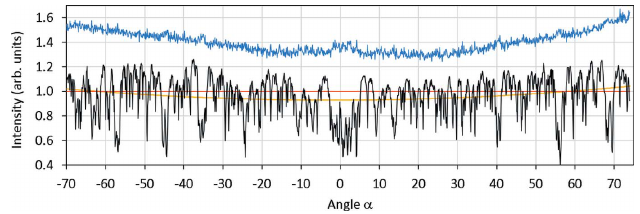
Figure 3 The blue line shows the total intensity in the Si cRED ED pattern as a function of goniometer angle (cid:5) , normalized to an average of unity and offset by 0.4. The black line shows the relative direct beam intensity for the data, normalized to an average of unity (red line). See also Fig.